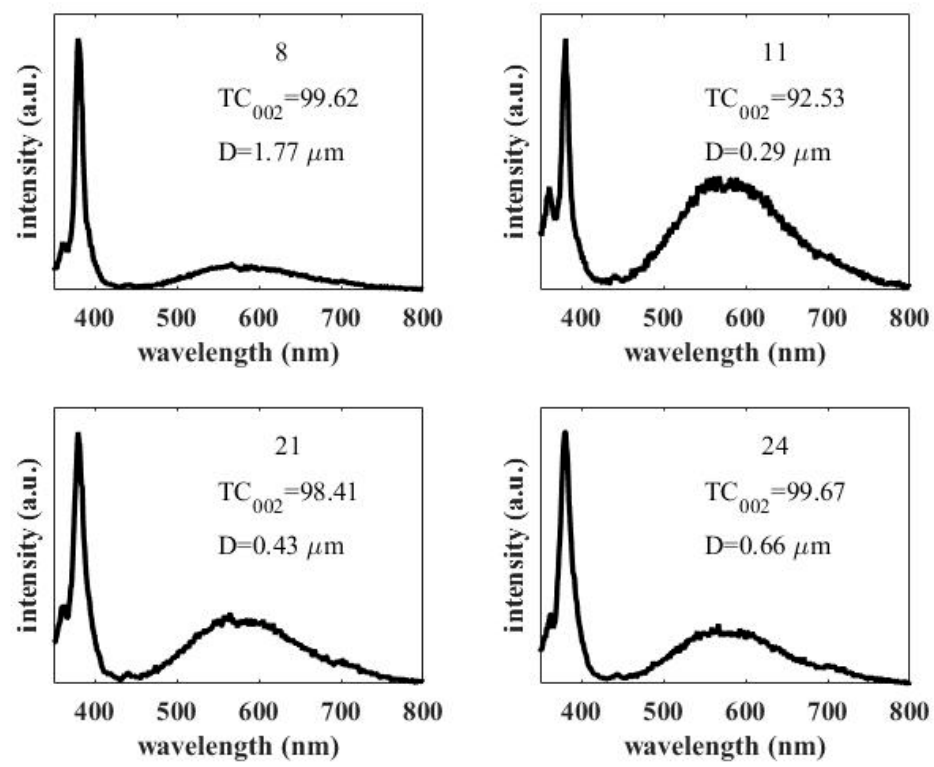
Figure 9. Photoluminescence spectra of the obtained ZnO rod arrays with different parameters. The number denoted above each spectrum represents the experiment number in Table 1.